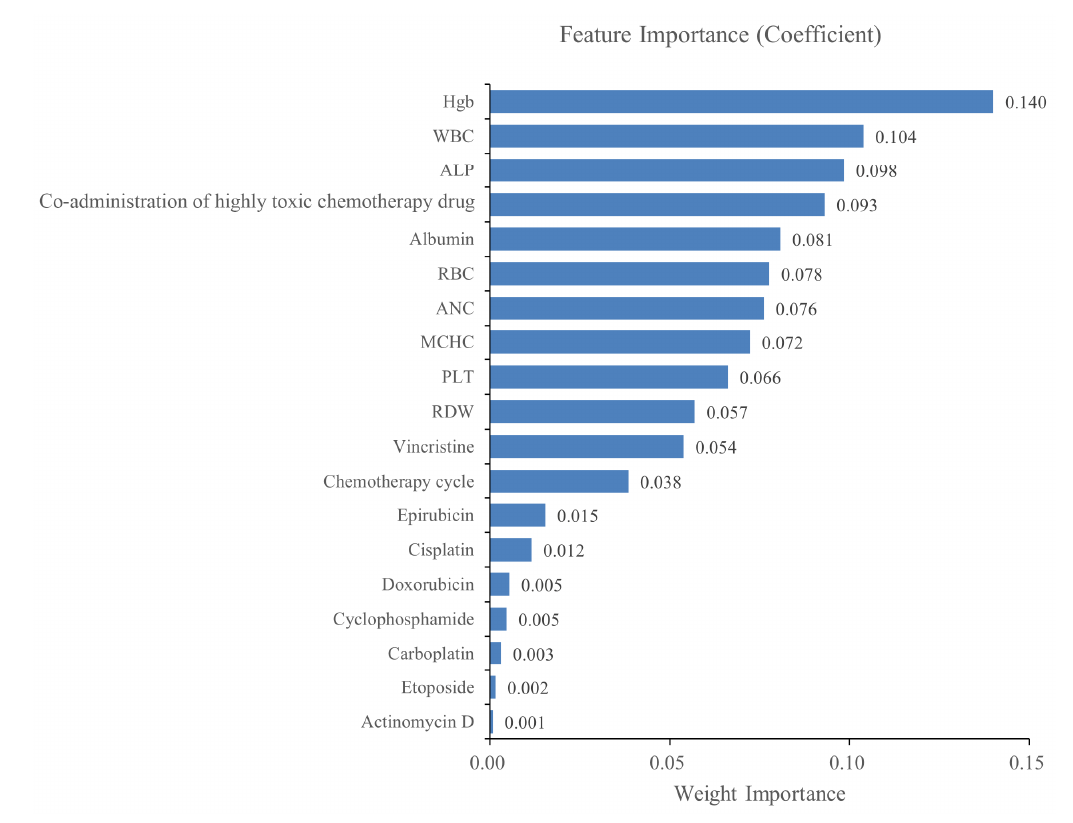
Figure 2. The ranking of feature importance in the XGB model. Briefly, the importance weight of a feature is the sum of the number of its occurrences in all decision trees. In other words, the more a feature is used to build a decision tree in the model, the higher its importance weight will be. Hgb: hemoglobin; WBC: white blood cell count; ALP: alkaline phosphatase; RBC: red blood cell count; MCHC: mean corpuscular hemoglobin concentration; PLT: platelet count; RDW: red blood cell distribution width.